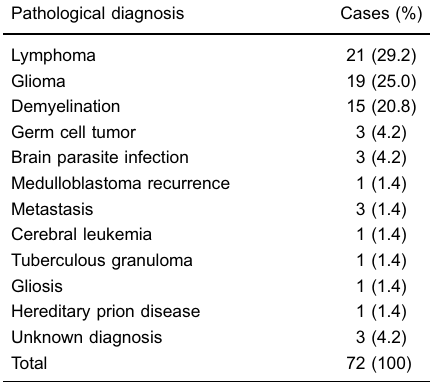
Table 2. Pathological results of 72 cases of intracerebral lesions from stereotactic biopsy. Pathological